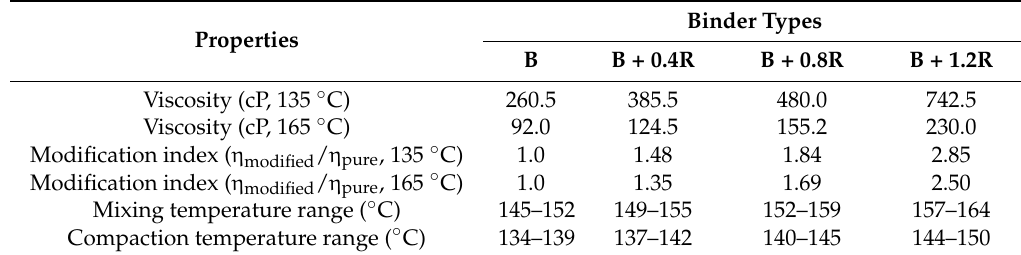
Figure 10. Temperature–viscosity relationship of binders. Table 5. Viscosities and processing temperatures of binders.